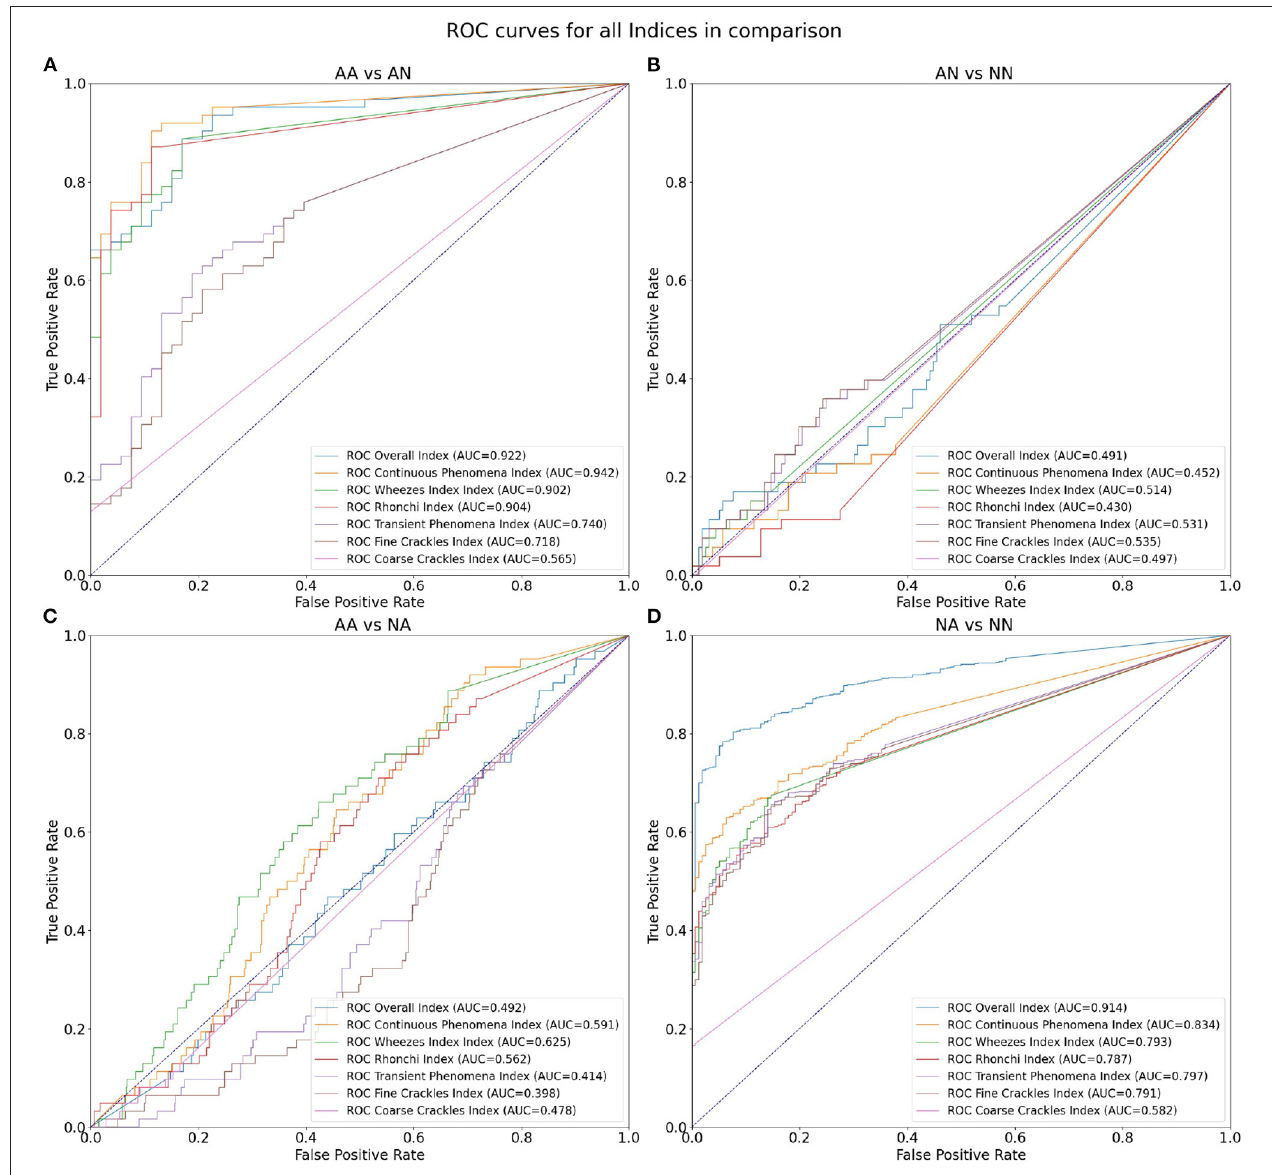
FIGURE 4 | ROC curves for all indices in comparison: (A) differentiation of AA and AN groups, (B) AN and NN groups, (C) AA and NA groups, and (D) NA and NN